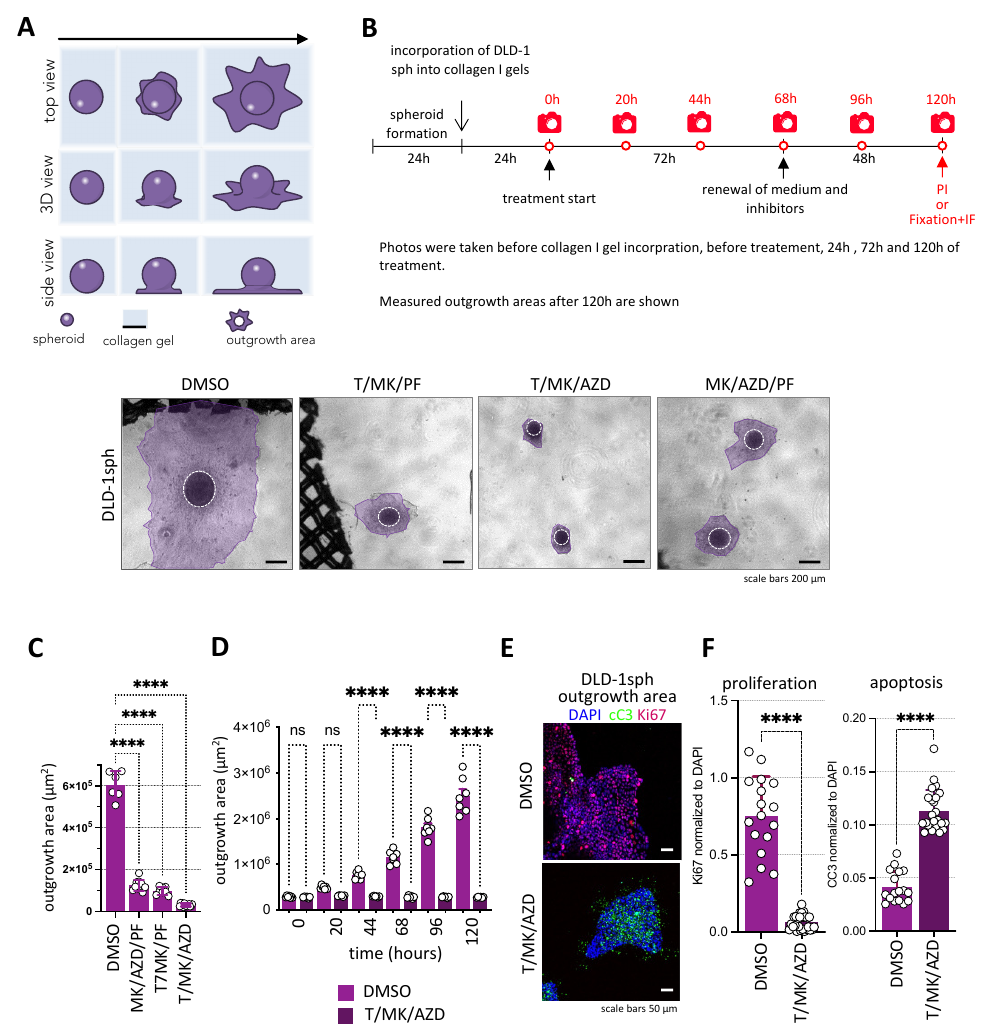
Figure 3. Colon cancer cell outgrowth on the surface of collagen I gels. ( A ) Schematic representation of the assay. ( B ) Overview of the time frame of the experiment. ( C ) DLD-1 spheroids were cultured in collagen I gels for 24 h and subsequently treated with triple-inhibitor combinations of Torin1 (250 nM), PF4708671 (10 µ M), MK2206 (1 µ M) and AZD6244 (1 µ M) for 5 days. DMSO served as control. ( C ) Representative phase contrast microscopic images of spheroids (encircled) and cancer cell outgrowth areas (purple) on the surface of the collagen I gels are shown. Scale bars represent 100 µ m. ( C ) After 72 h of treatment the outgrowth areas of DLD-1 spheroids on the collagen I gel was measured. Total outgrowth areas were normalized to the respective DMSO controls ( n = 4–14 per condition). P-values are indicated (One-way ANOVA post normality test). ( D ) Spheroid outgrowth area (in µ m 2 ) over time in DMSO vs. T/MK/AZD. ( E ) Representative confocal immunofluorescence pictures showing Ki67 (red) and cleaved caspase 3 (cC3, green) levels in spheroid outgrowth regions under T/MK/AZD compared to DMSO controls. Cell nuclei in blue (DAPI). ( F ) Quantification of mean fluorescence intensities (MFI) of cC3 and Ki67 normalized to DAPI in five different spheroids at three different optical sections each in confocal images. Error bars are SD, dots indicate fluorescence intensity of individual images. p values are indicated by